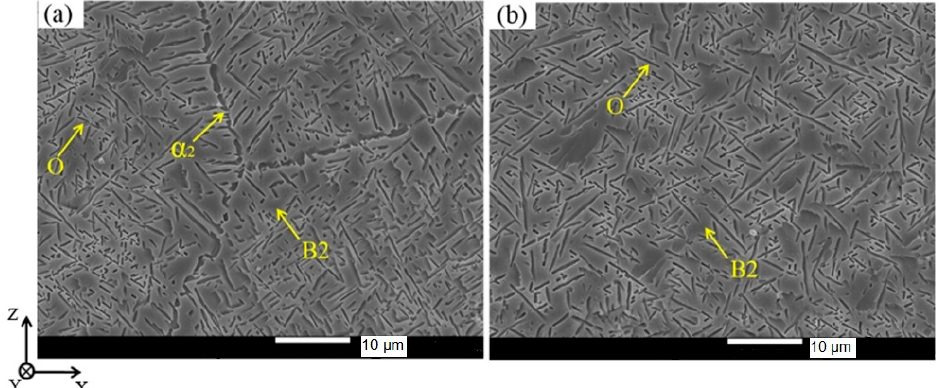
Figure 8. Typical microstructures of O-phase based Ti alloys produced by WAAM: ( a ) with grain boundary and ( b ) without grain boundary. Reproduced with permission from Elsevier [67].